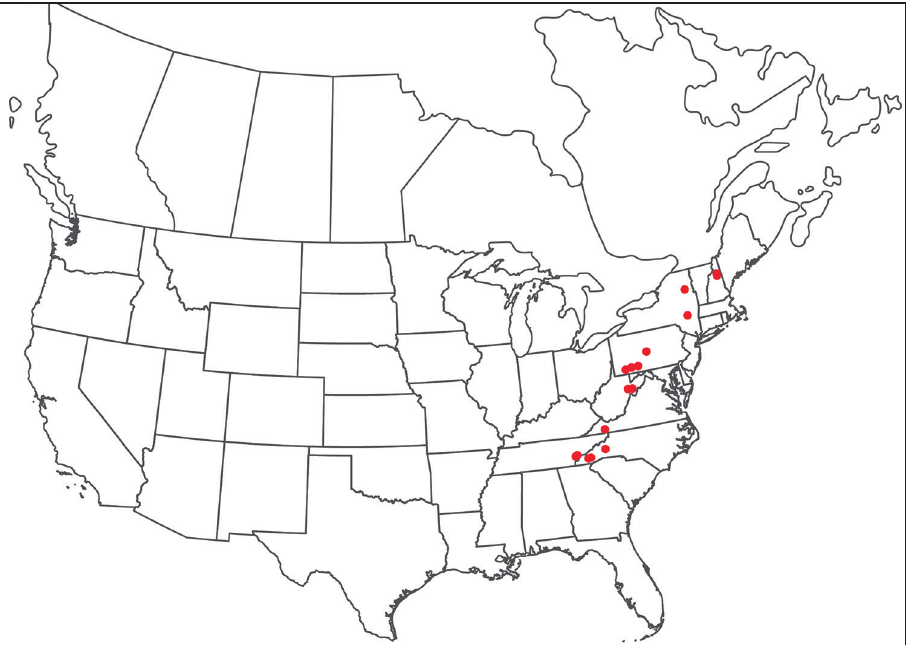
Figure 243. Torrenticola skvarlai sp. n.